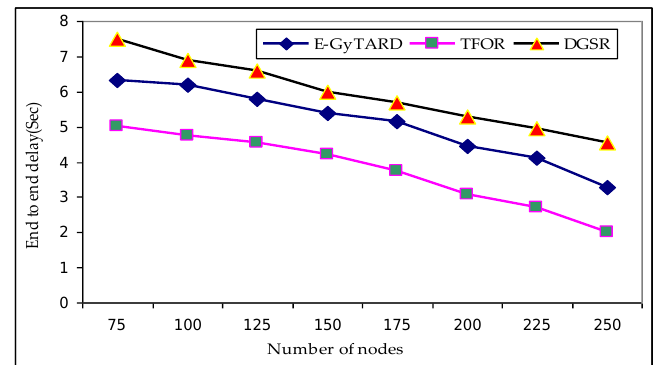
Figure 11. End-to-end delay vs. the number of nodes (@5 packets/s ).